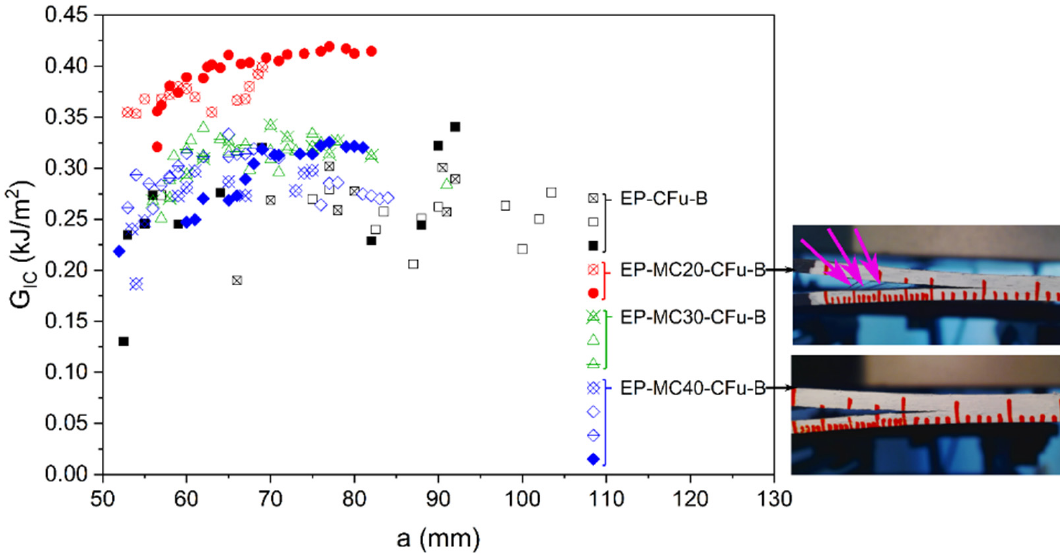
Figure 4. Results of the interlaminar fracture toughness tests. R-curves of the laminates EP-MCx-CFu-B and pictures of the EP-MC20-CFu-B specimens (arrows indicate fiber bridging) and EP-MC40-CFu-B (no evidence of fiber bridging). The results of two to four specimens are shown for each sample. Reprinted with permission from [41]. Table 2. Mode I critical strain energy release rates for crack initiation ( G Ii and steady-state propaga- tion ( G Ic ) for the laminates EP-MCx-CFu-B. Reprinted with permission from [41].